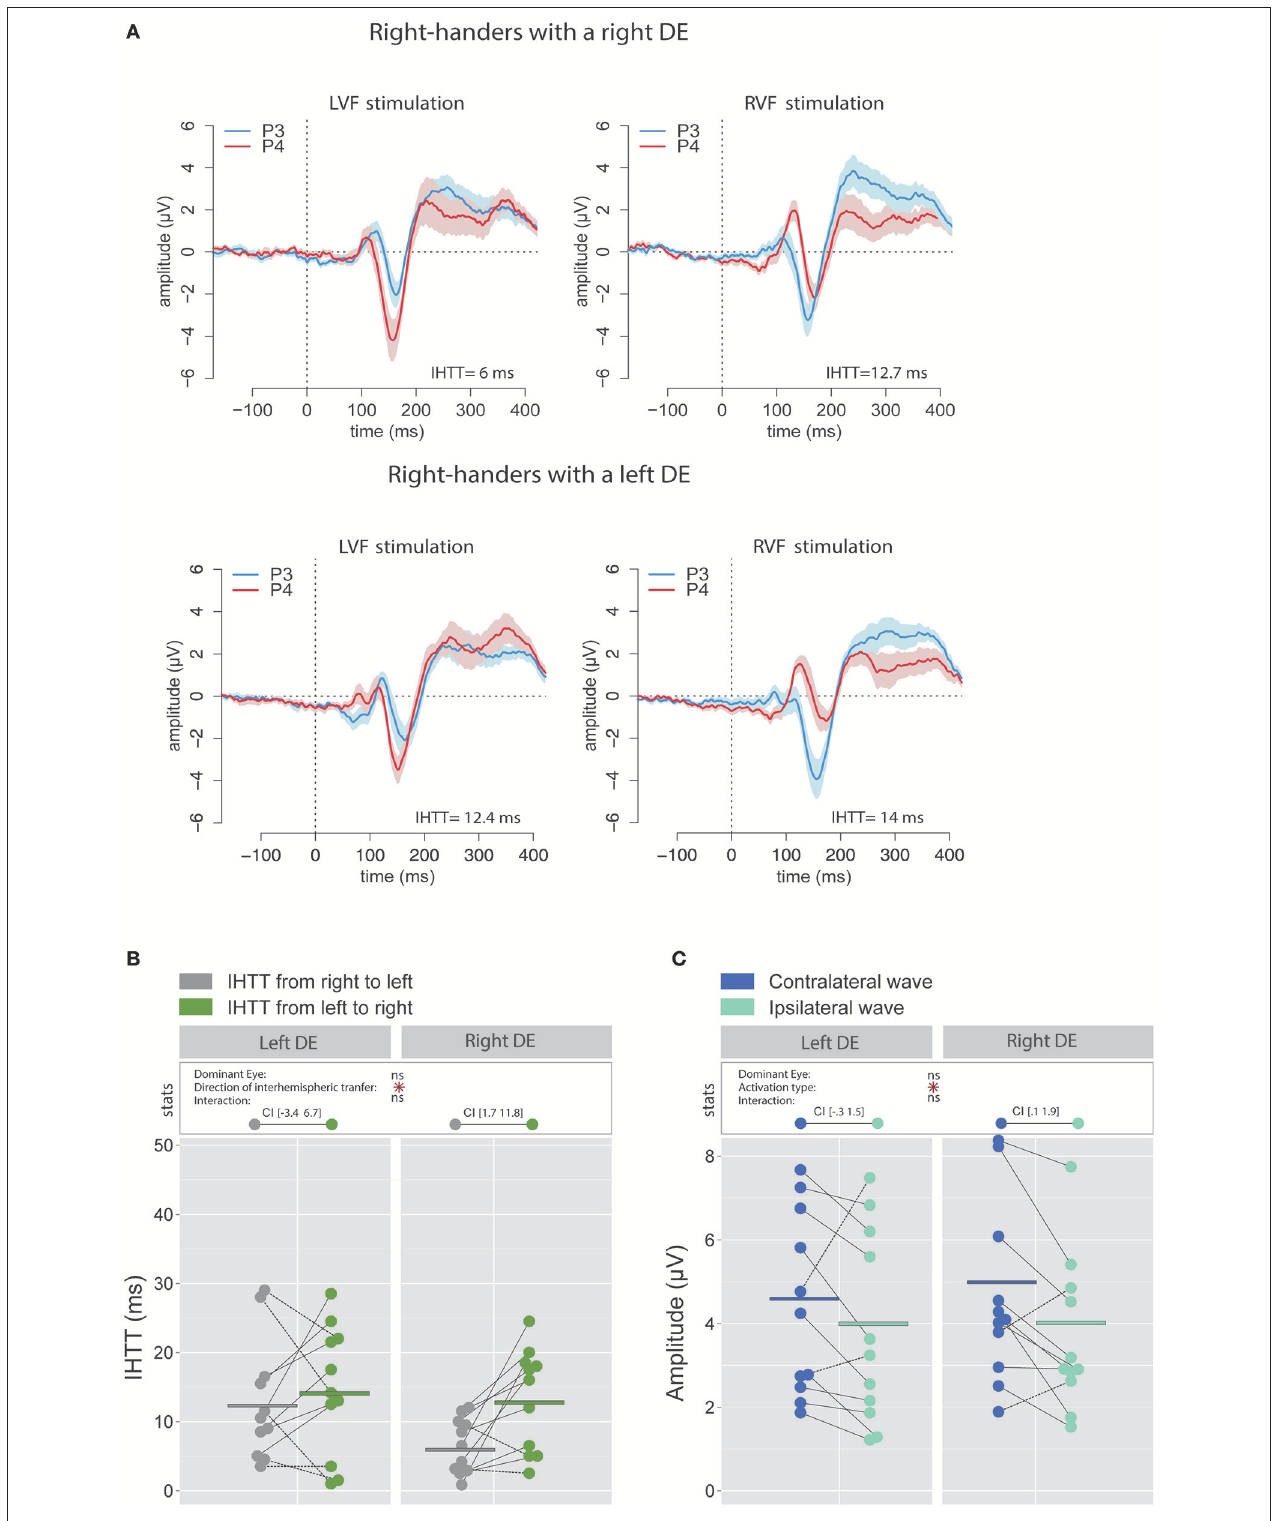
FIGURE 4 | Waveforms and average results from bipolar recordings computed over posterior sites. (A) Grand average bipolar waveforms recorded over P3 (blue waves) and P4 (red waves) electrodes in the two experimental conditions (LVF or RVF stimulation). Shading blue and red areas represent the SEM across